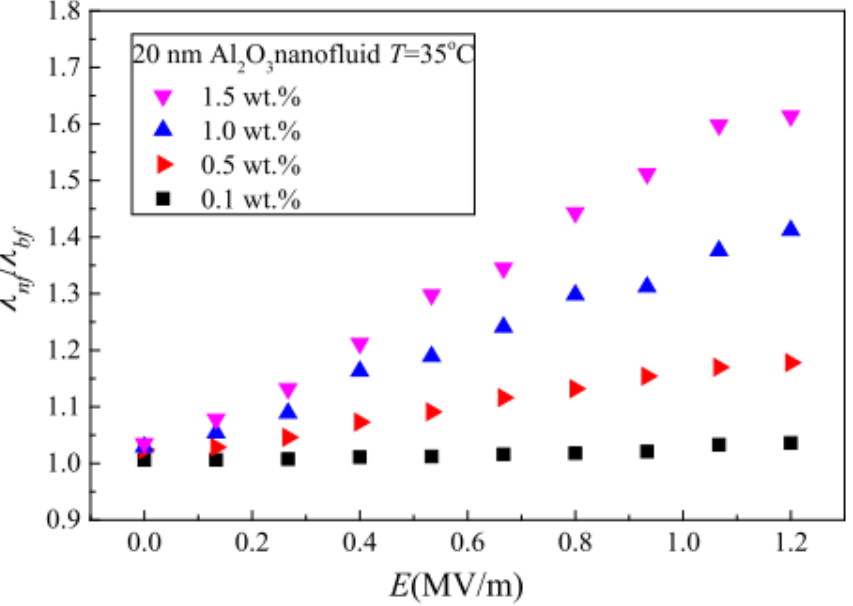
Figure 10. Effect of increasing electric field intensity and concentration on thermal conductivity of 20 nm—Al 2 O 3 nanofluid at 35 °C [138].